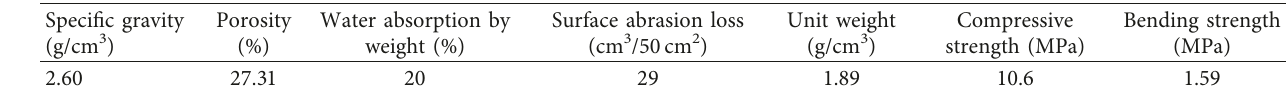
Table 6: Chemical and mechanical properties of Ahlat stone.